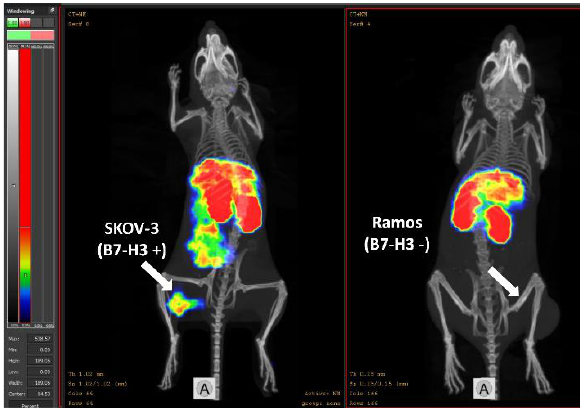
Figure 9. Imaging of B7-H3-positive SKOV-3 xenograft (tumour in the left mouse) and B7-H3-negative Ramos xenograft (tumour in the right mouse) in BALB/C nu/nu mice using [ 99m Tc]Tc-AC12-GGGC 4 h after injection. 3 µg of labelled Affibody molecule (6 MBq, 100 µL in PBS) was injected into the tail vein. Arrows point at tumours.